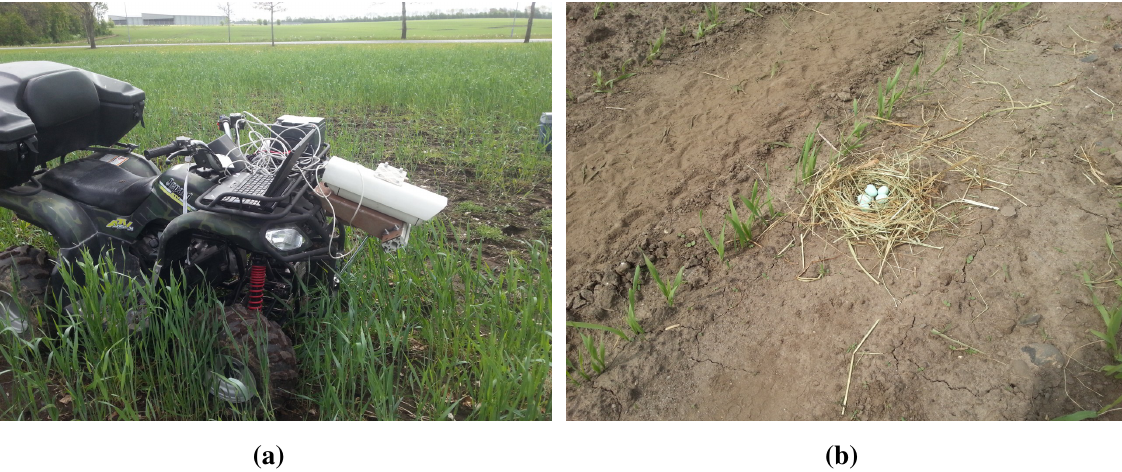
Figure 1. Photos from data collection. ( a ) Thermo-visual setup mounted on an all-terrain vehicle; ( b ) man-made skylark nest with heated plastic